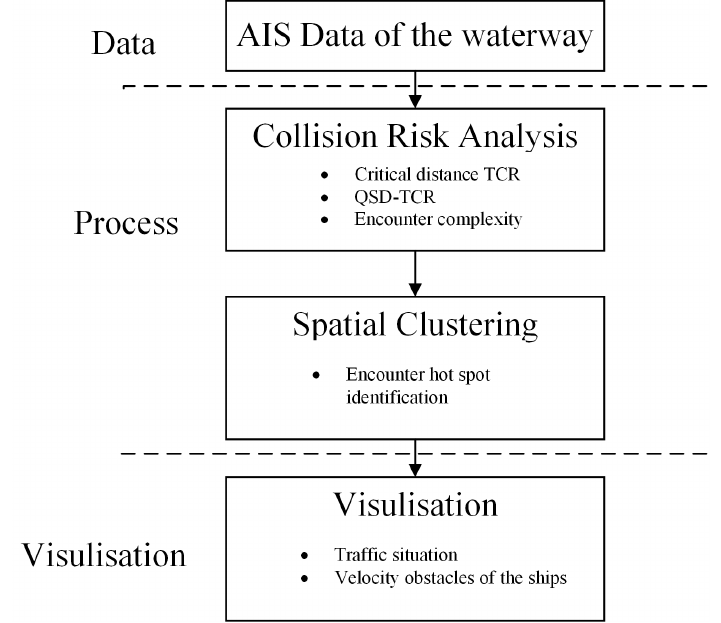
Figure 1. Framework of the proposed collision risk analysis method.